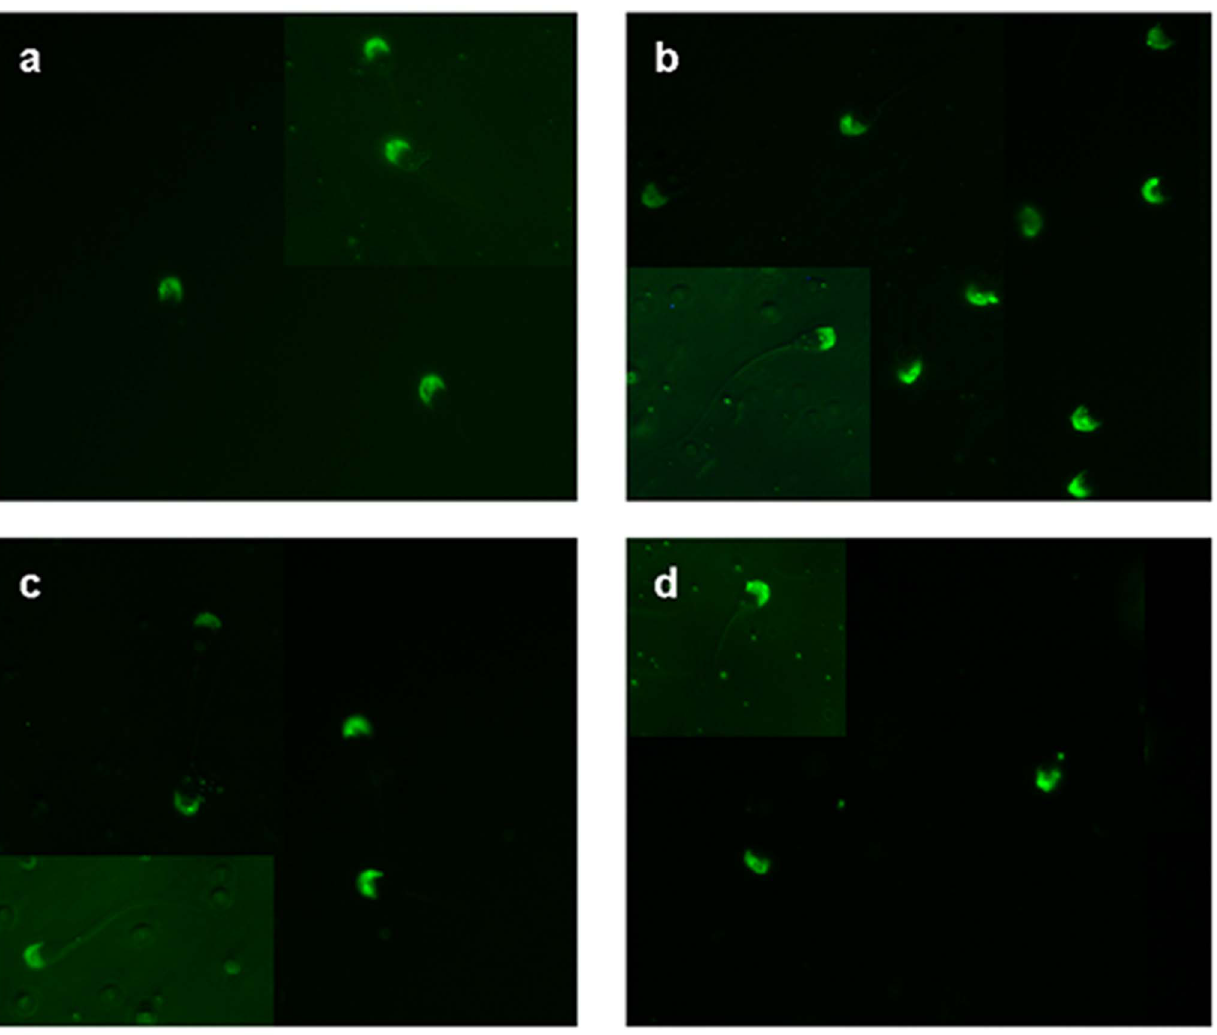
Figure 2. Sperm from the Brahman bull used in this study with: a) fluorescein conjugated Type-2 tissue inhibitor of metalloproteinase (TIMP-2) antibody revealing natural levels and location of TIMP-2 protein, b) fluorescein conjugated TIMP-2 recombinant protein adsorption by sperm, c) fluorescein conjugated fertility associated antigen (FAA) antibody revealing natural levels and location of FAA protein, and d) fluorescein conjugated FAA recombinant protein adsorption by sperm.